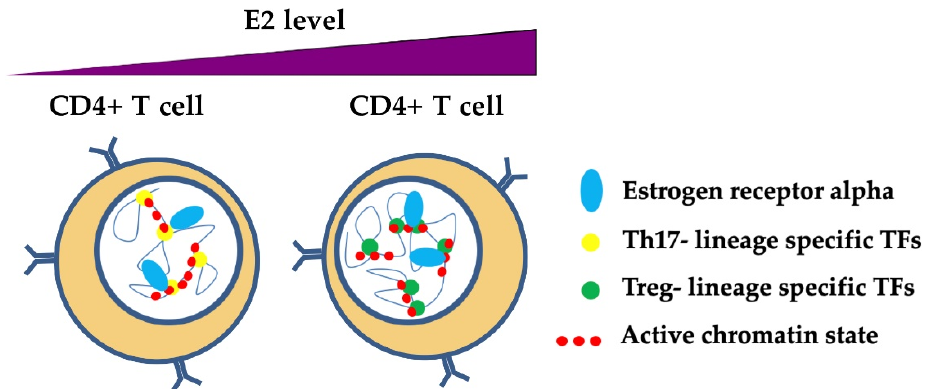
Figure 5. A model of ER α -dependent modulation of nuclear organization of chromatin in T helper cells. Estrogens participate in the mechanisms of transcriptional regulation through the binding of ER α at regulatory regions, thereby influencing the phenotype of T helper cells. Estrogens at normal levels promote the binding and activation of Th17 lineage-specific TFs (e.g., RORC ), whereas estrogens at pregnancy levels bind preferentially to Treg lineage-specific TFs, thus inhibiting RORC and promoting FOXP3 transcriptional activation [90]. ER α may participate with TFs that are specific for Th17 and Treg lineages in chromatin remodeling in these cells, although the mechanisms are still unclear.